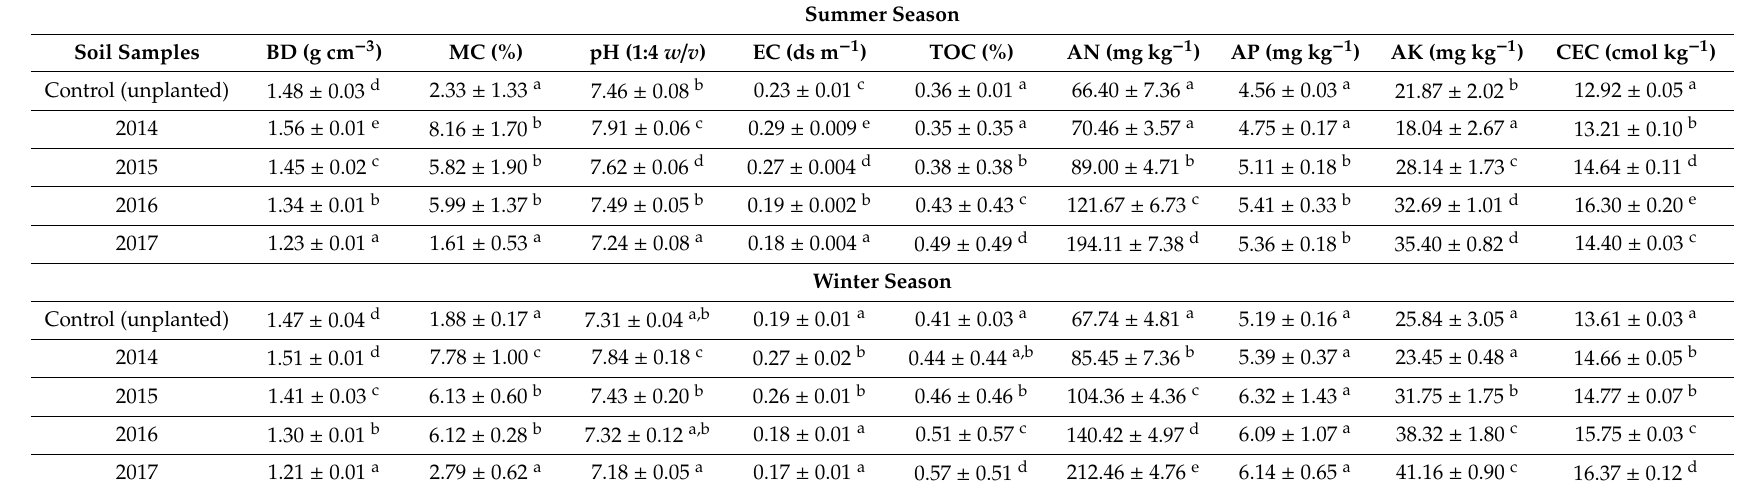
Note: values with di ff erent letters in a particular column are significantly di ff erent at the 95% confidence level ( p ≤ 0.05) as per